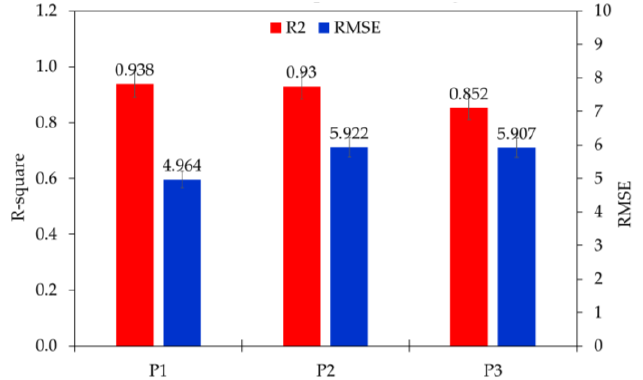
Figure 13. Cross-well prediction using RF.